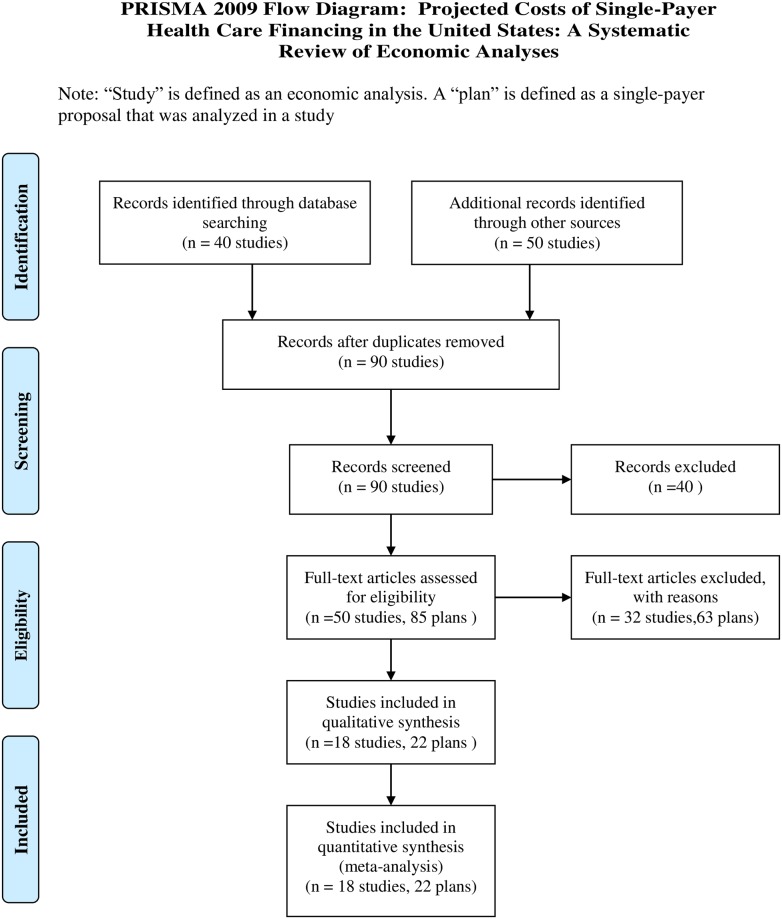
PRISMA flow diagram.